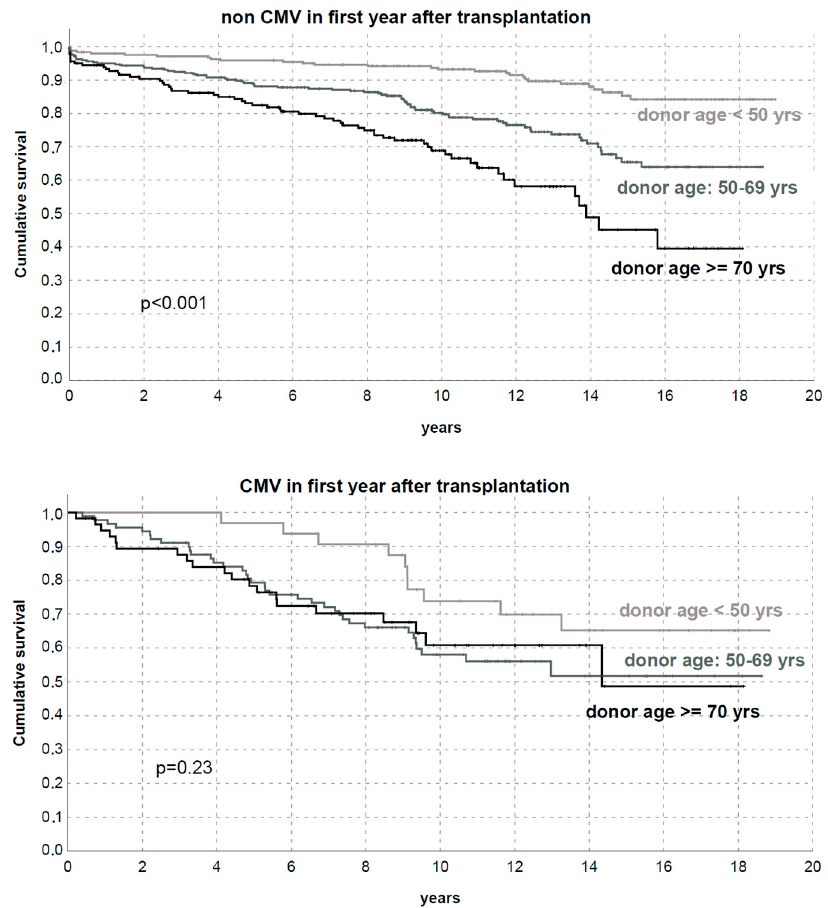
Figure 7. Death-censored graft survival by donor age (<50 years, 50–69 years, or ≥ 70 years) with or without CMV replication/disease in the first year after transplantation.